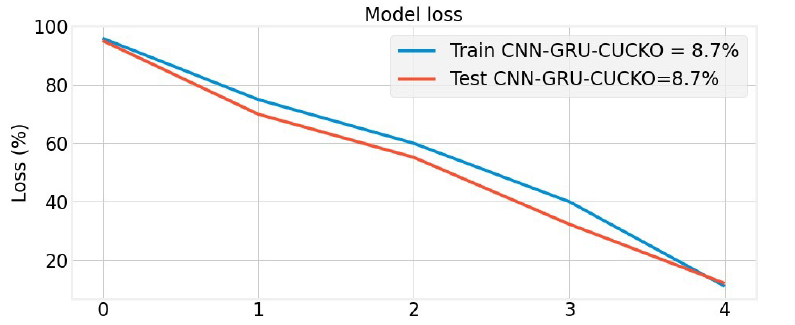
Figure 10. Proposed model loss vs.